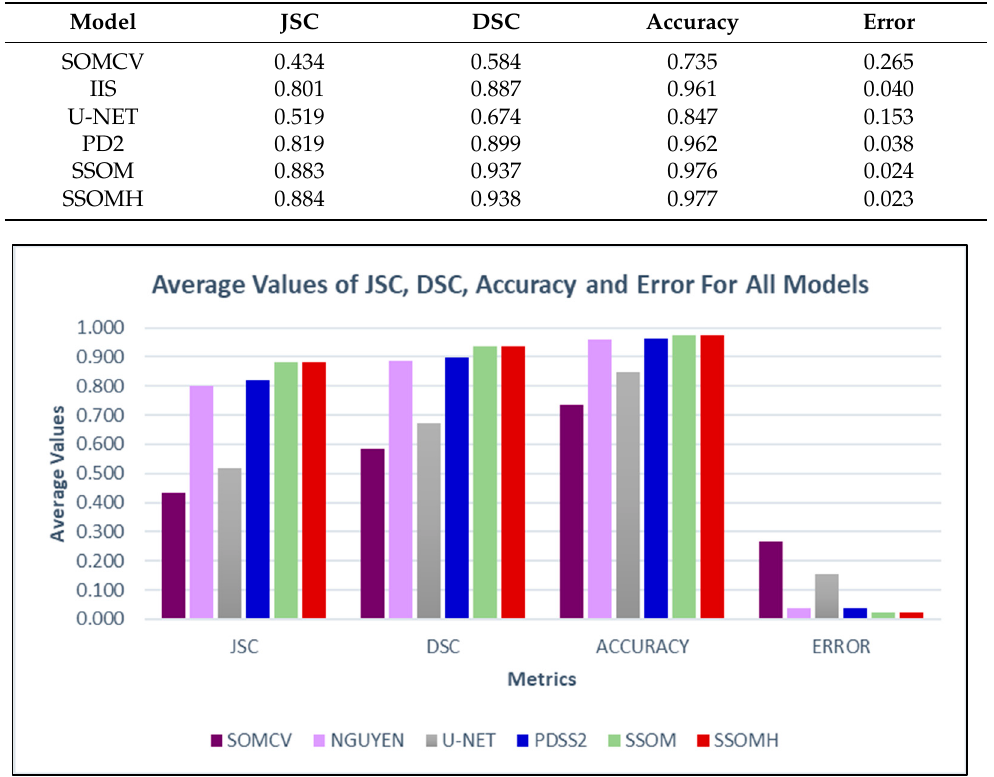
Figure 4. Average Values of JSC, DSC, Accuracy and Error for All Models.